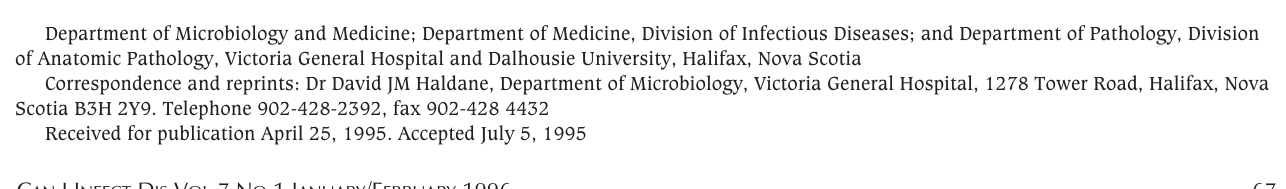
D irofilaria species cause a filarial infection in